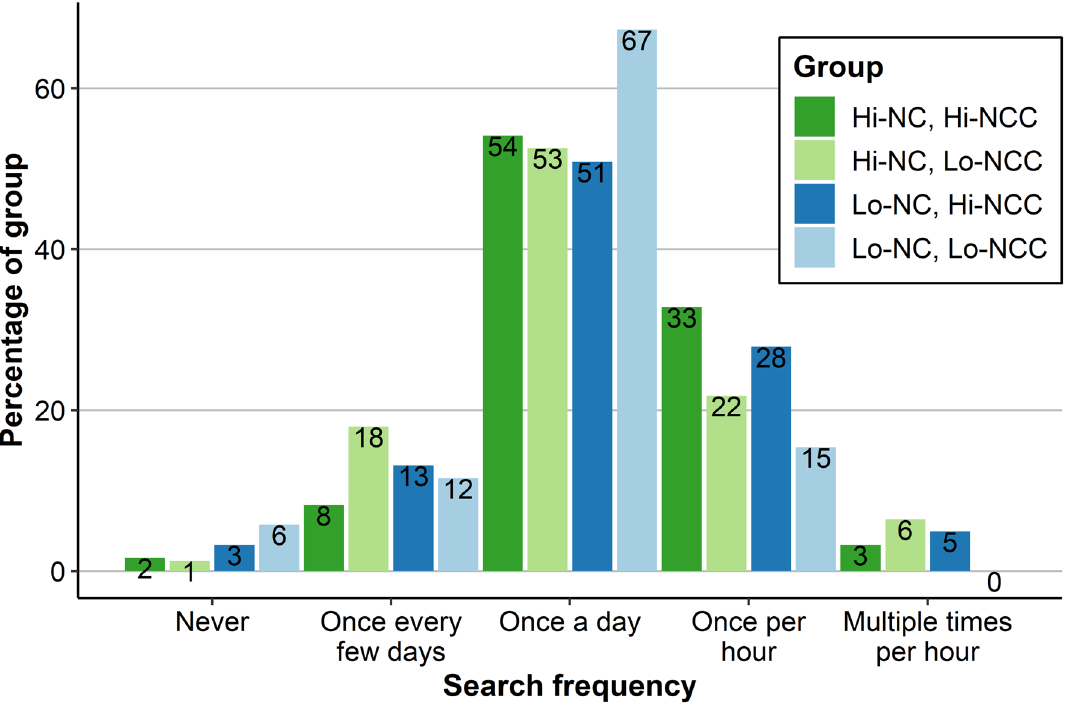
Figure 3. Media use frequency. COVID-19 Information Search Frequency Compared Across NC and NCC Types.